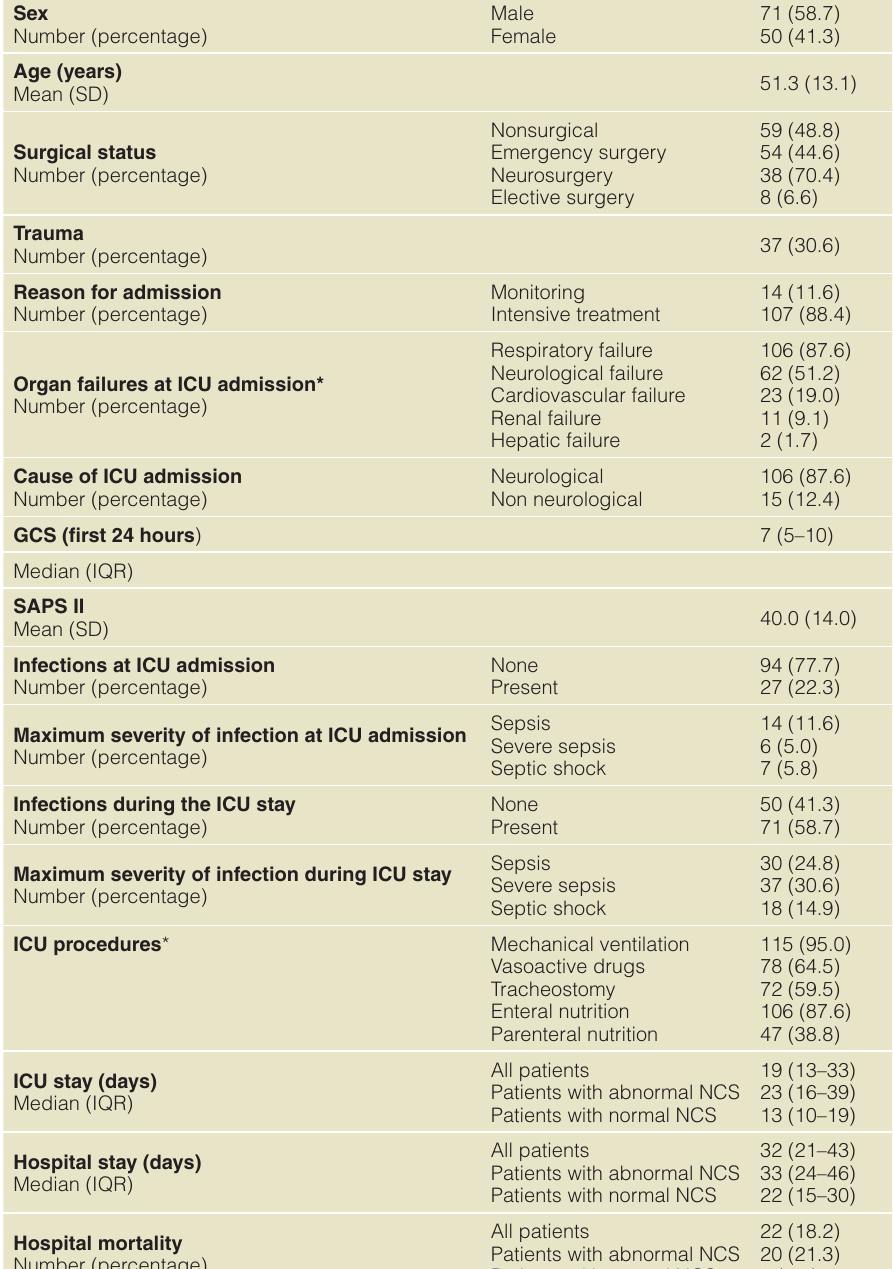
Table 1. Demographic characteristics, clinical severity and outcome of the study population (121 patients). GCS: Glasgow Coma Scale; SAPS: Simplified Acute Physiology Score. NCS: nerve conduction